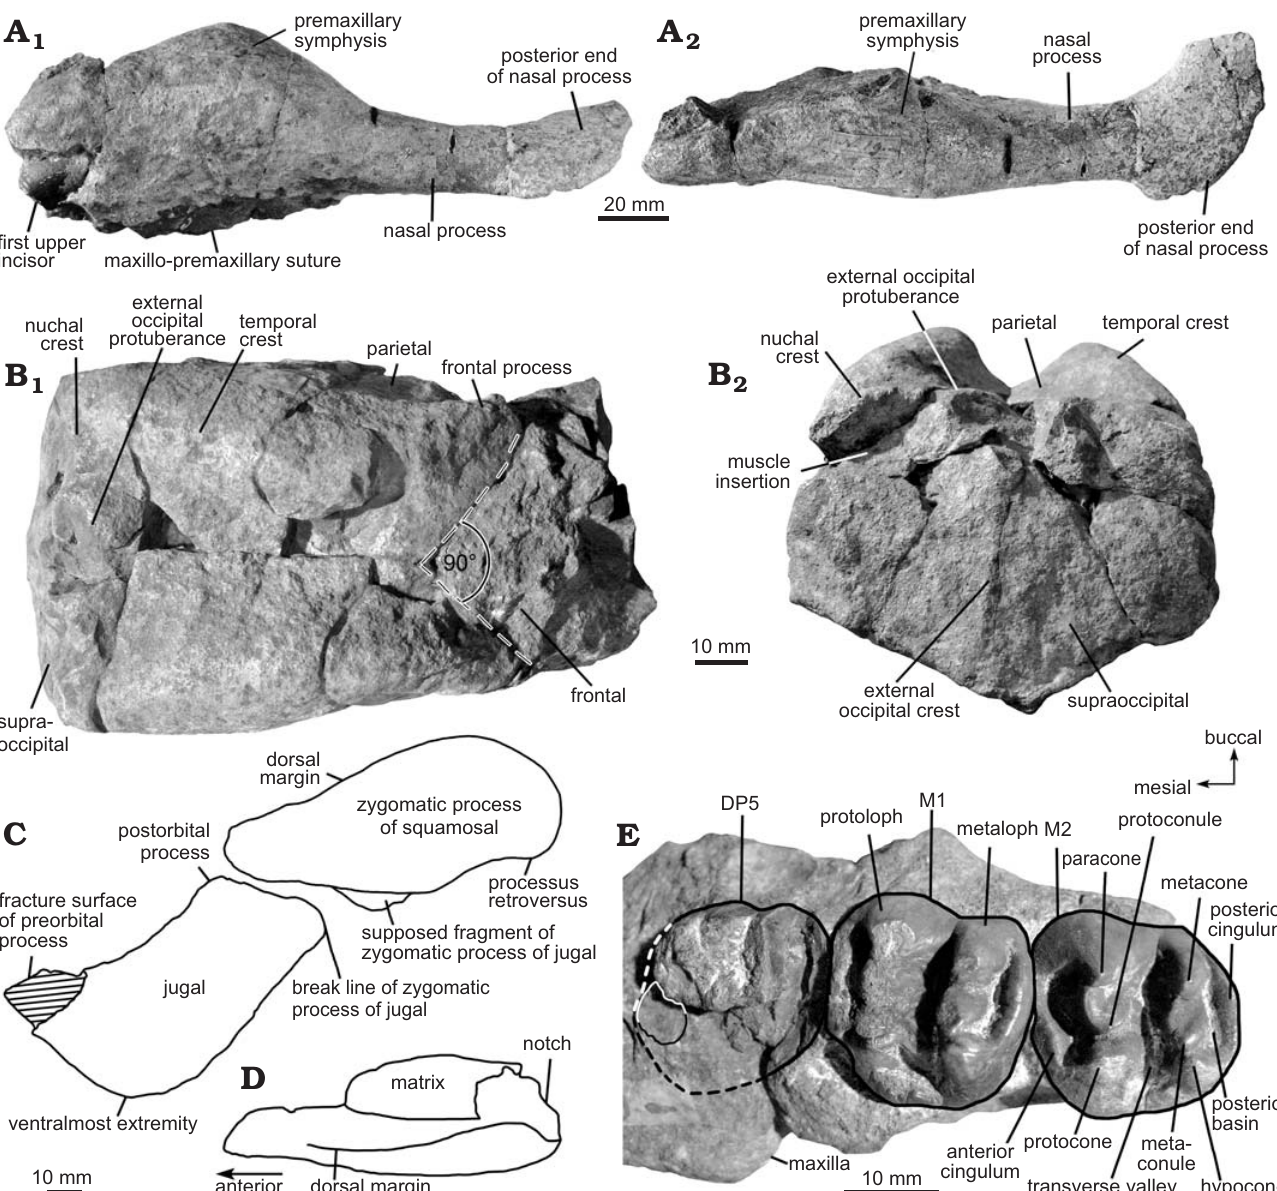
Fig. 2. Cranial and dental elements of the dugongine sirenian Italosiren bellunensis (De Zigno, 1875) comb. nov. from Cavar zano, Italy; upper Chattian, late Oligocene. A . Left premaxilla (MGPD-19Z) in lateral (A 1 ) and dorsal (A 2 ) views. B . Parietal-supraoccipital skullcap (MGPD-18Z) in dorsal (B 1 ) and posterior (B 2 ) views. C . Outline drawing of left zygomatic process of squamosal (MGPD-22Z) and jugal (MGPD-7384Z) in lateral view; shaded area in- dicates missing part. D . Outline drawing of left zygomatic process of squamosal (MGPD-22Z) in dorsal view. E . Left maxillary fragment (MGPD-20/21Z) in occlusal view; dashed lines indicate the estimated outline of DP5, outlined area indicates portion of controversial interpretation and is considered here as representing remnants of the DP5